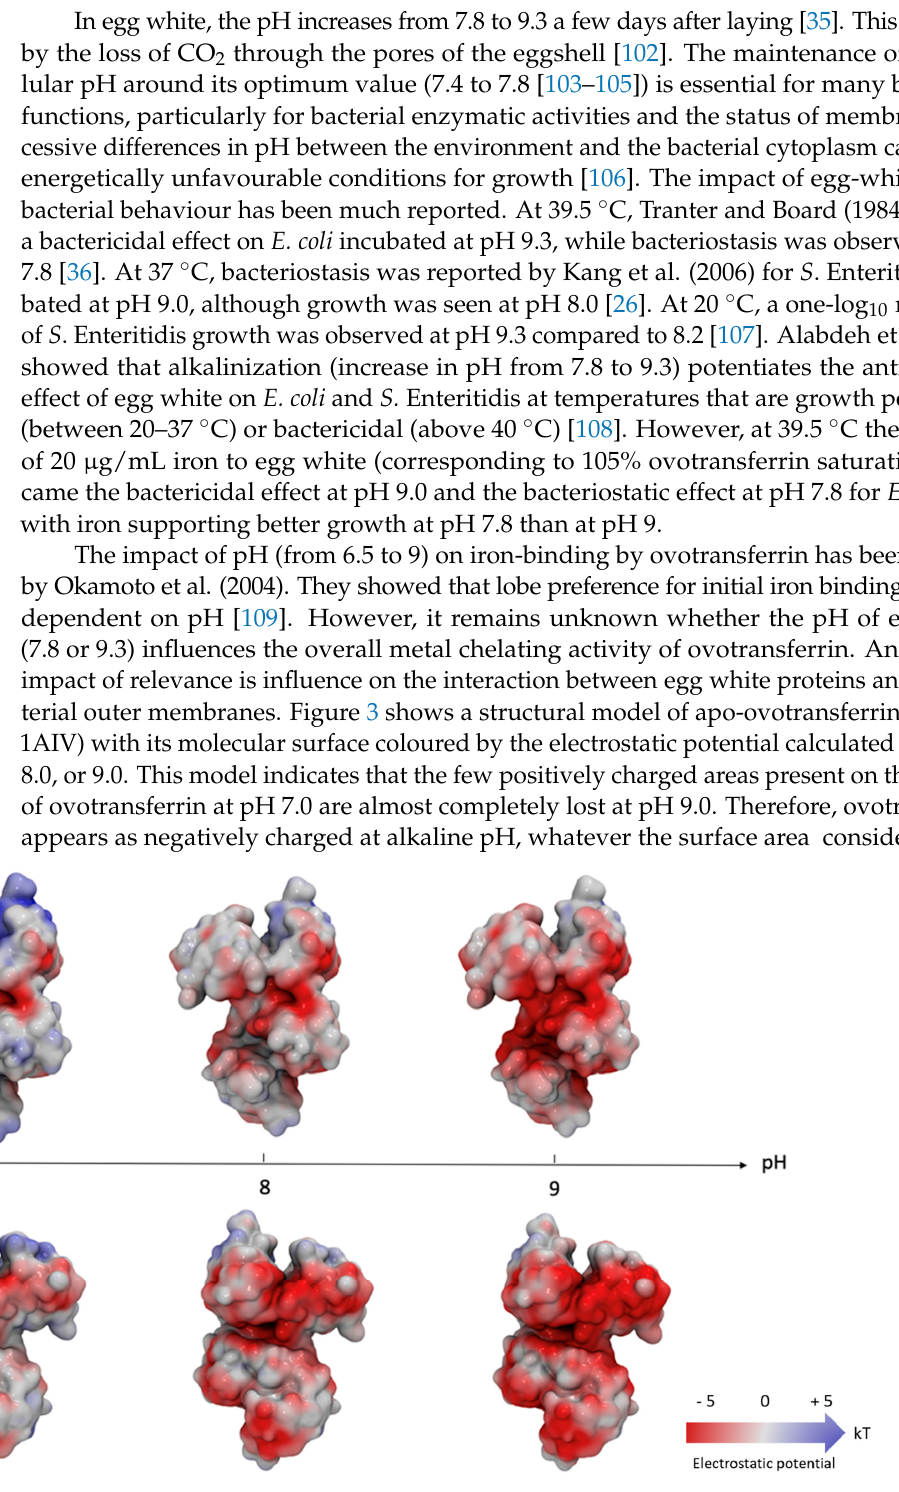
Figure 3. Prediction of electrostatic charge distribution at the surface of ovotransferrin. Each representation ( A ) and ( B ) corresponds to a rotation of the molecule by 180° around the vertical axis. Charges were computed at each pH using the PDB2PQR tool [110] and the electrostatic potential of the protein surface was estimated with the APBS tool [111], using a specific server (https://server.poissonboltzmann.org/ (accessed on 15 January 2021)). The molecule was visualised using the VMD software [112]. The surface of each molecule is coloured according to the electrostatic potential, from -5 kT (red) to + 5 kT (blue), via 0 kT (white), where k is the Boltzmann constant and T the absolute temperature. The impact of the pH-related change in surface charge on ovotransferrin function (e.g., interaction with bacterial surfaces and or metals ions) remains largely unexplored. Moreover, it was shown that ovotransferrin provokes a stronger depolarization of the cy- toplasmic membrane of the Gam-positive B. cereus at pH 9.3 than at neutral pH [101]. The precise influence of egg white pH on the membrane perturbation activity of ovotransferrin requires further investigation (especially for S. Enteritidis). 5.2. Impact of the Ionic Composition of Egg White Studies investigating the antimicrobial activity of ovotransferrin have been per- formed mainly in minimal or rich model media under a range of iron regimes. However,